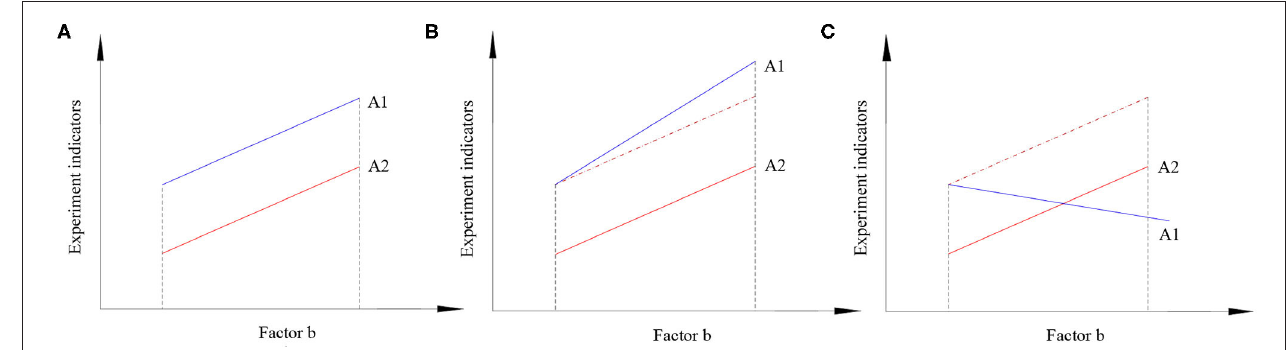
FIGURE 1 | The working period of CLS backfill applied in upward sublevel filling method. (A) Before filling; (B) cold releasing; (C) cold fully released.